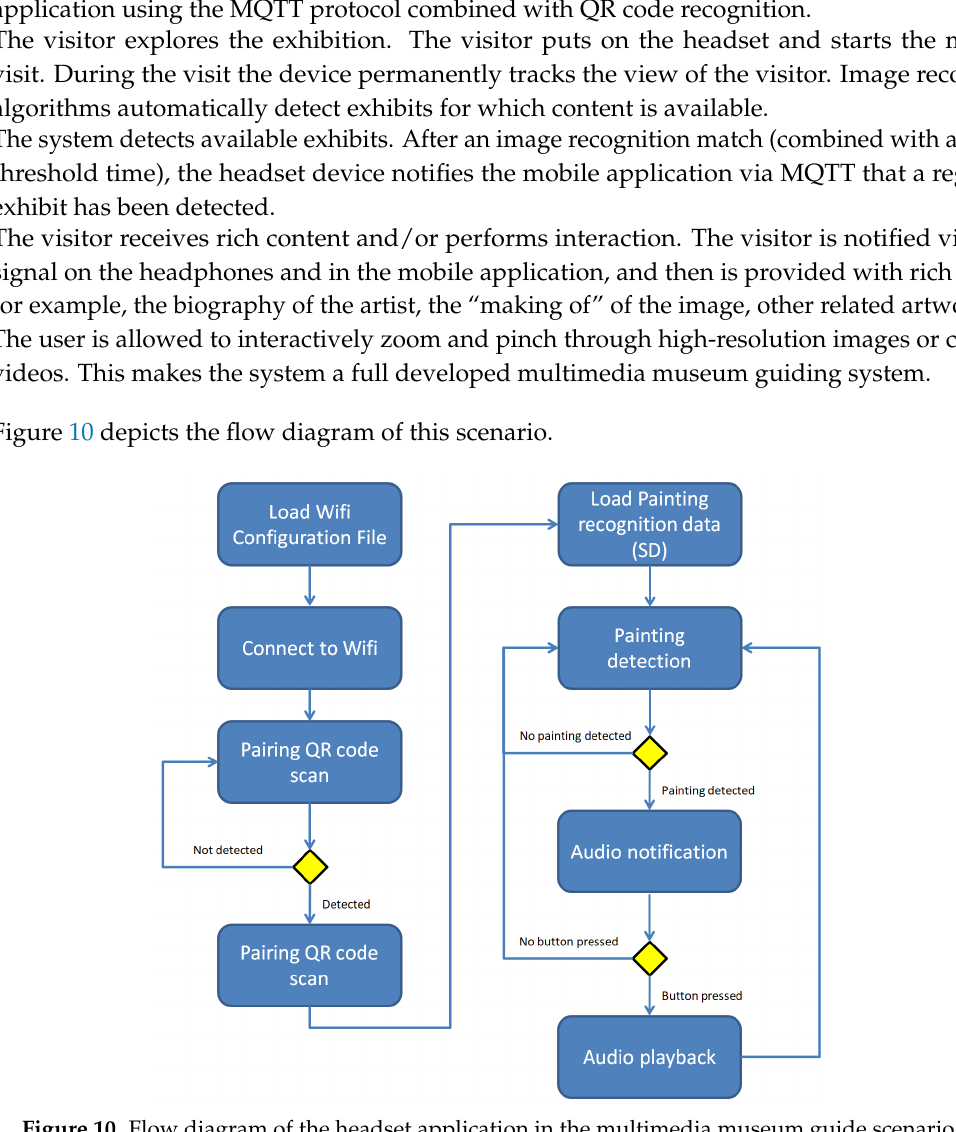
Figure 10. Flow diagram of the headset application in the multimedia museum guide